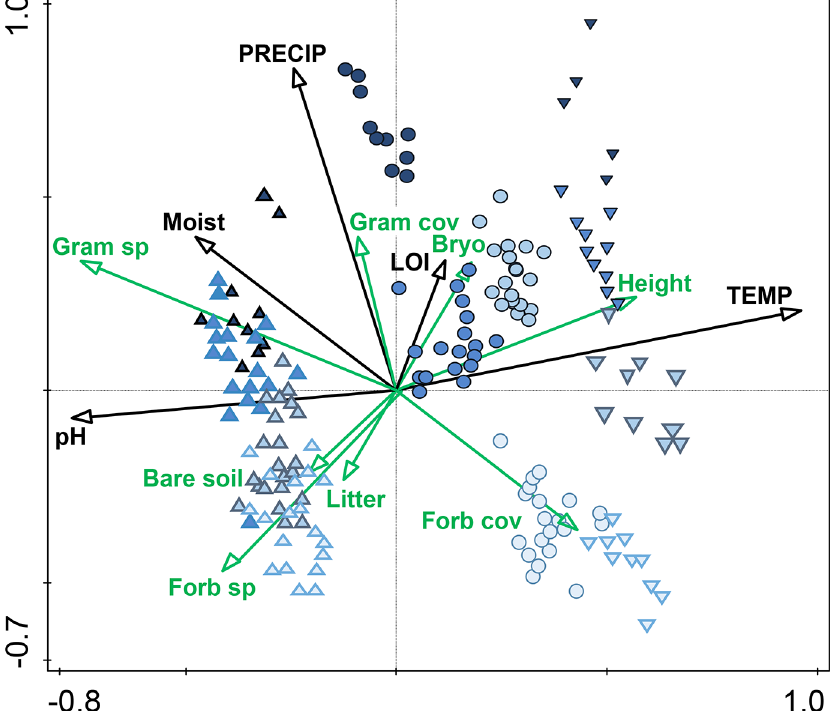
Fig 2. Overall ordination of the grid. Canonical correspondence analysis (CCA) of measured biotic (green) and abiotic (black) environmental variables and alpine ( ▲ ), sub-alpine ( ● ) and boreal ( ▼ ) sites along a precipitation gradient (1 – 4 from light to dark blue, see Fig 1) in southern Norway. LOI refers to Loss-On- Ignition, a measure of soil organic matter. Eigenvalues axis 1 = 0.472, axis 2 = 0.248, axis 3 = 0.182, axis 4 = 0.137. Only the two first axes are